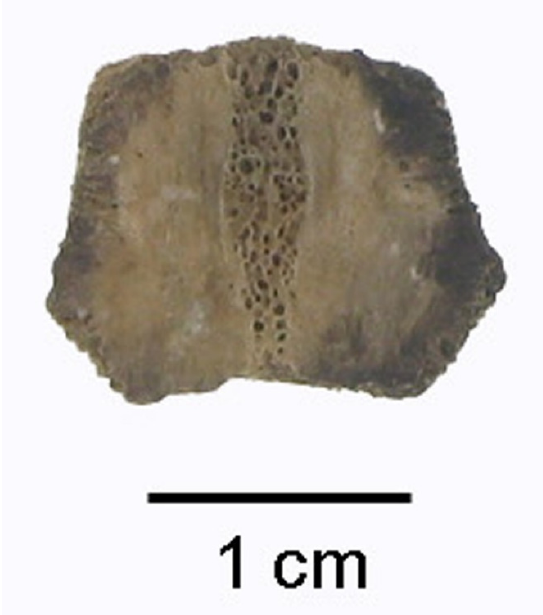
Figure 6. Cut turtle bone, south units (75/80), level 3.